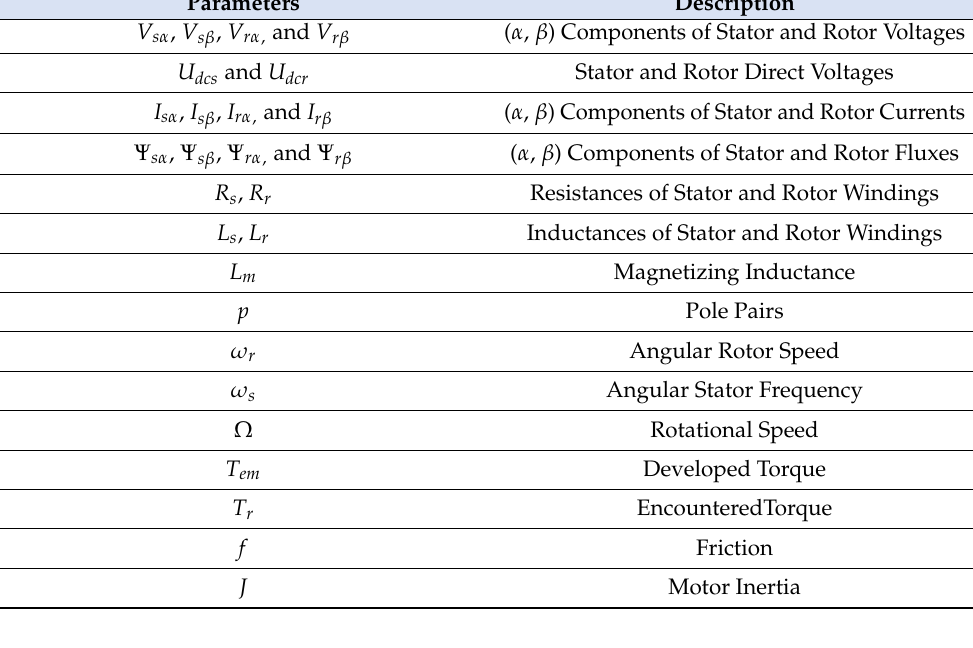
Table A3. Nomenclature.